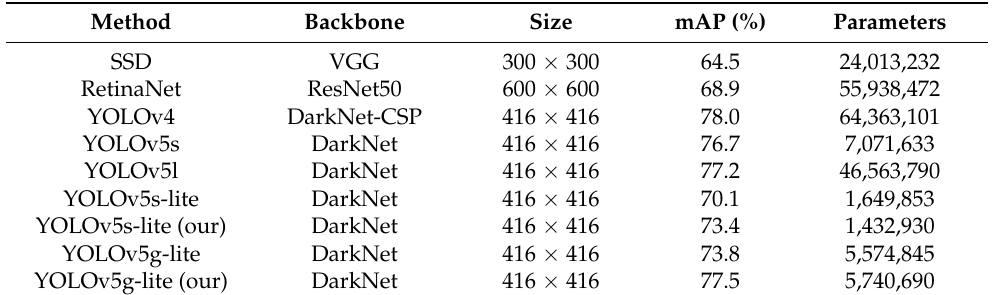
Table 2. Comparison of detection performance and number of parameters of different algorithms.